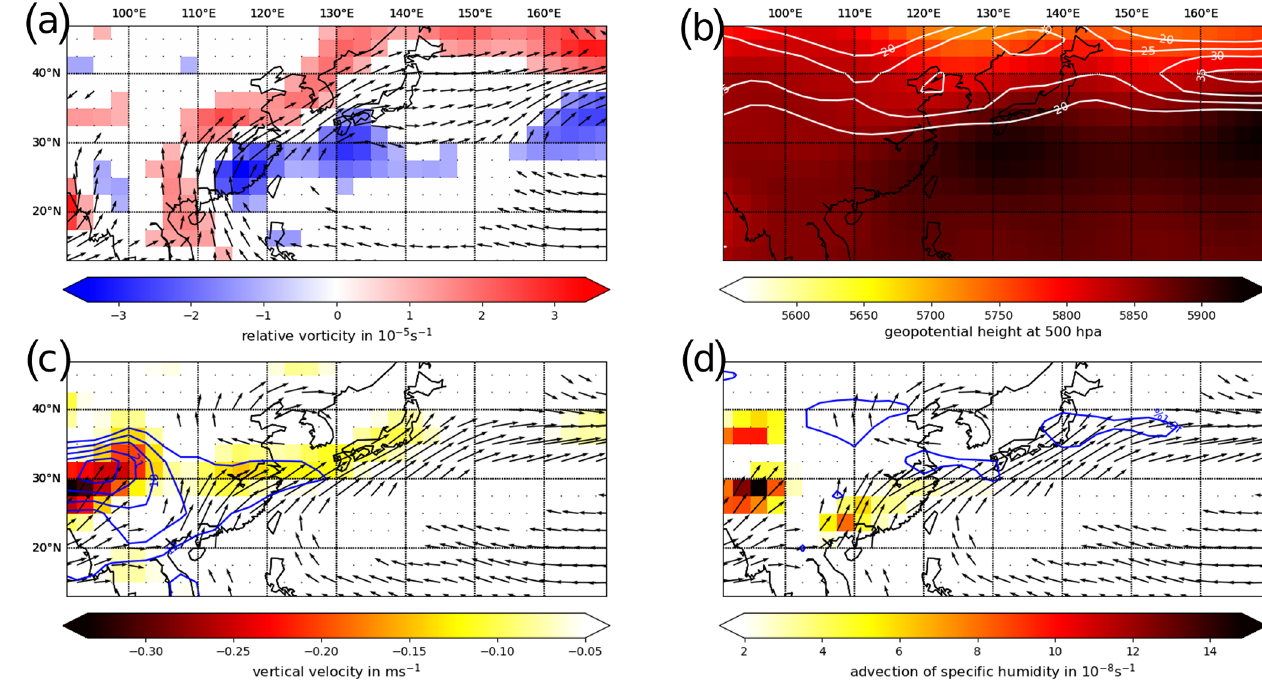
Figure 9. (a) Average (29 June–3 July 1998) 850hPa winds with speed larger than 5ms − 1 and relative vorticity larger than 10 − 5 s − 1 (red tones) and smaller than − 10 − 5 s − 1 (blue tones). (b) Average (29 June–3 July 1998) 500hPa geopotential height (shaded) and 200hPa wind speed larger than 20ms − 1 (white contours). (c) Average (25–30 June 1999) 850hPa winds with speeds larger than 5ms − 1 , specific humidity larger than 12gkg − 1 (blue contour, interval 3gkg − 1 ) and 700hPa updraft vertical velocity larger than 0 . 05Pas − 1 (shaded). (d) Winds are the same as in (c) but are combined with specific humidity advection larger than 2 × 10 − 8 s − 1 (shaded) and divergence at − 0 . 01ms − 1 (i.e., convergence, blue